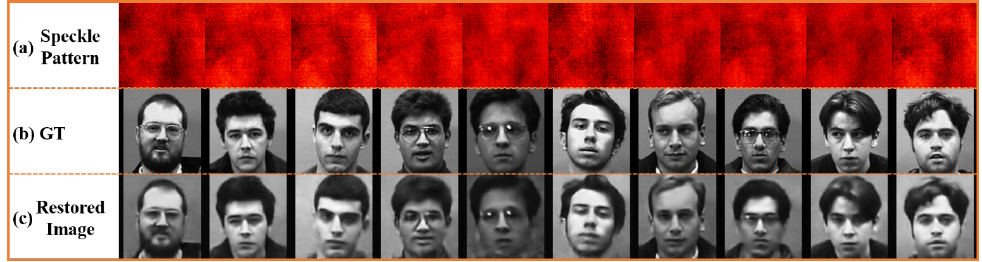
Figure 5. The reconstruction result of the face data set by AESINet. ( a ) The Speckle pattern. ( b ) The Ground Truth (GT) of the hidden face. ( c ) The reconstruction results by using adaptive